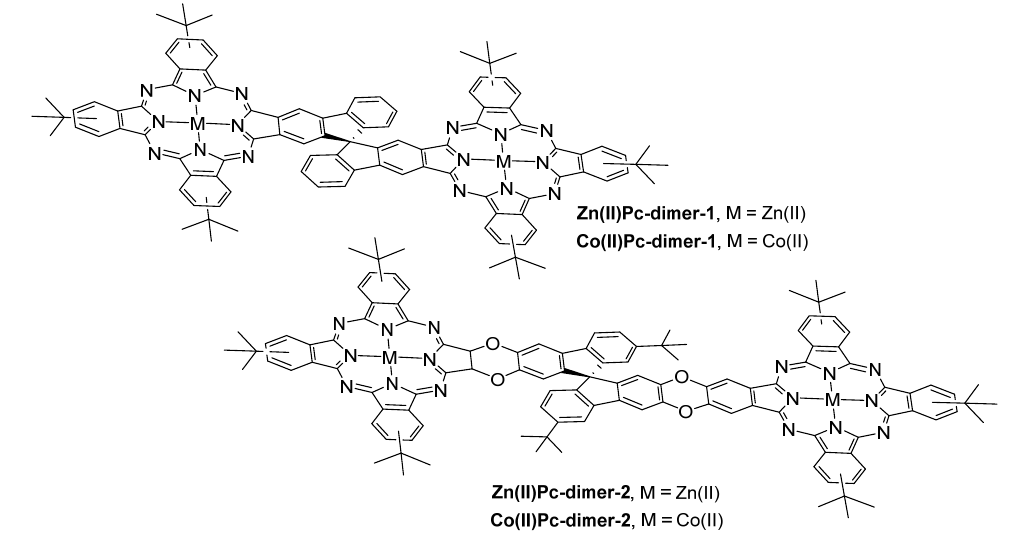
Figure 15. Structures of Zn(II) and Co((II) phthalocyanine dimers M(II)Pc-dimer-1 and M(II)Pc-dimer-2 connected with twisted linkers (adapted from [63]).